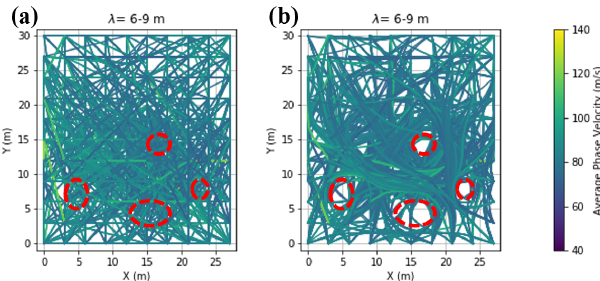
Figure 15. The computed ray paths for the data points with wavelengths in the range of 6–9m for the Pijnacker field dataset from (a) the last iteration of the straight-ray inversion and (b) the last iteration of the curved-ray SWT inversion. The colours of ray paths correspond to the computed path-averaged phase velocity along the path. The red dashes show the areas where the coverage of ray paths from straight-ray and curved-ray SWT are considerably